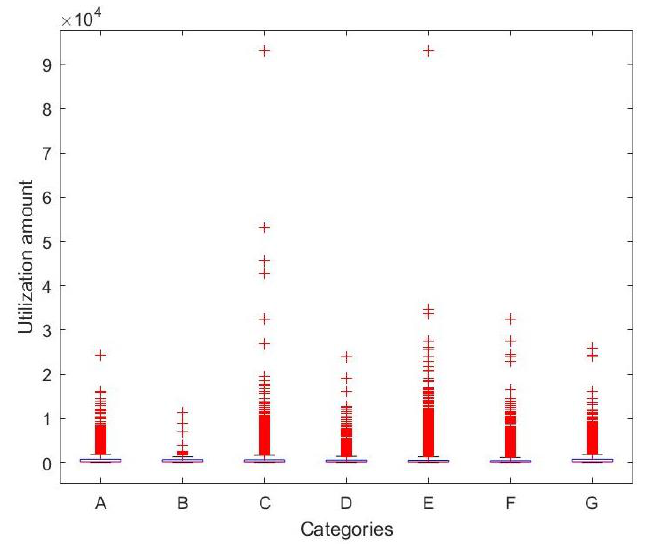
Figure 14. Out of pocket employees in original data.